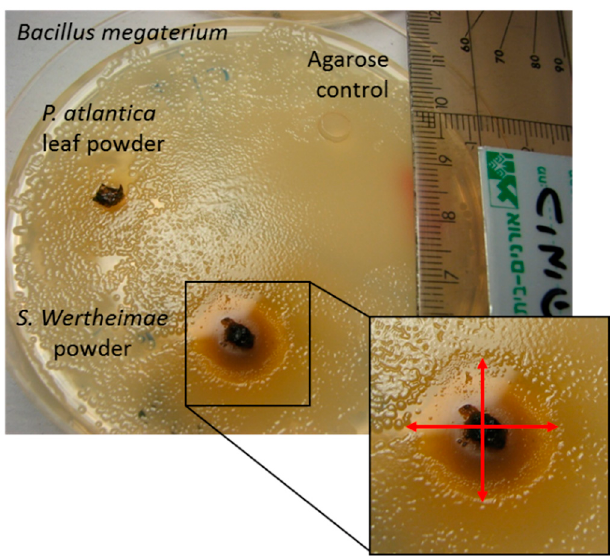
Figure 2. Well diffusion assay. The red lines demonstrate the measurement of inhibition diameter.